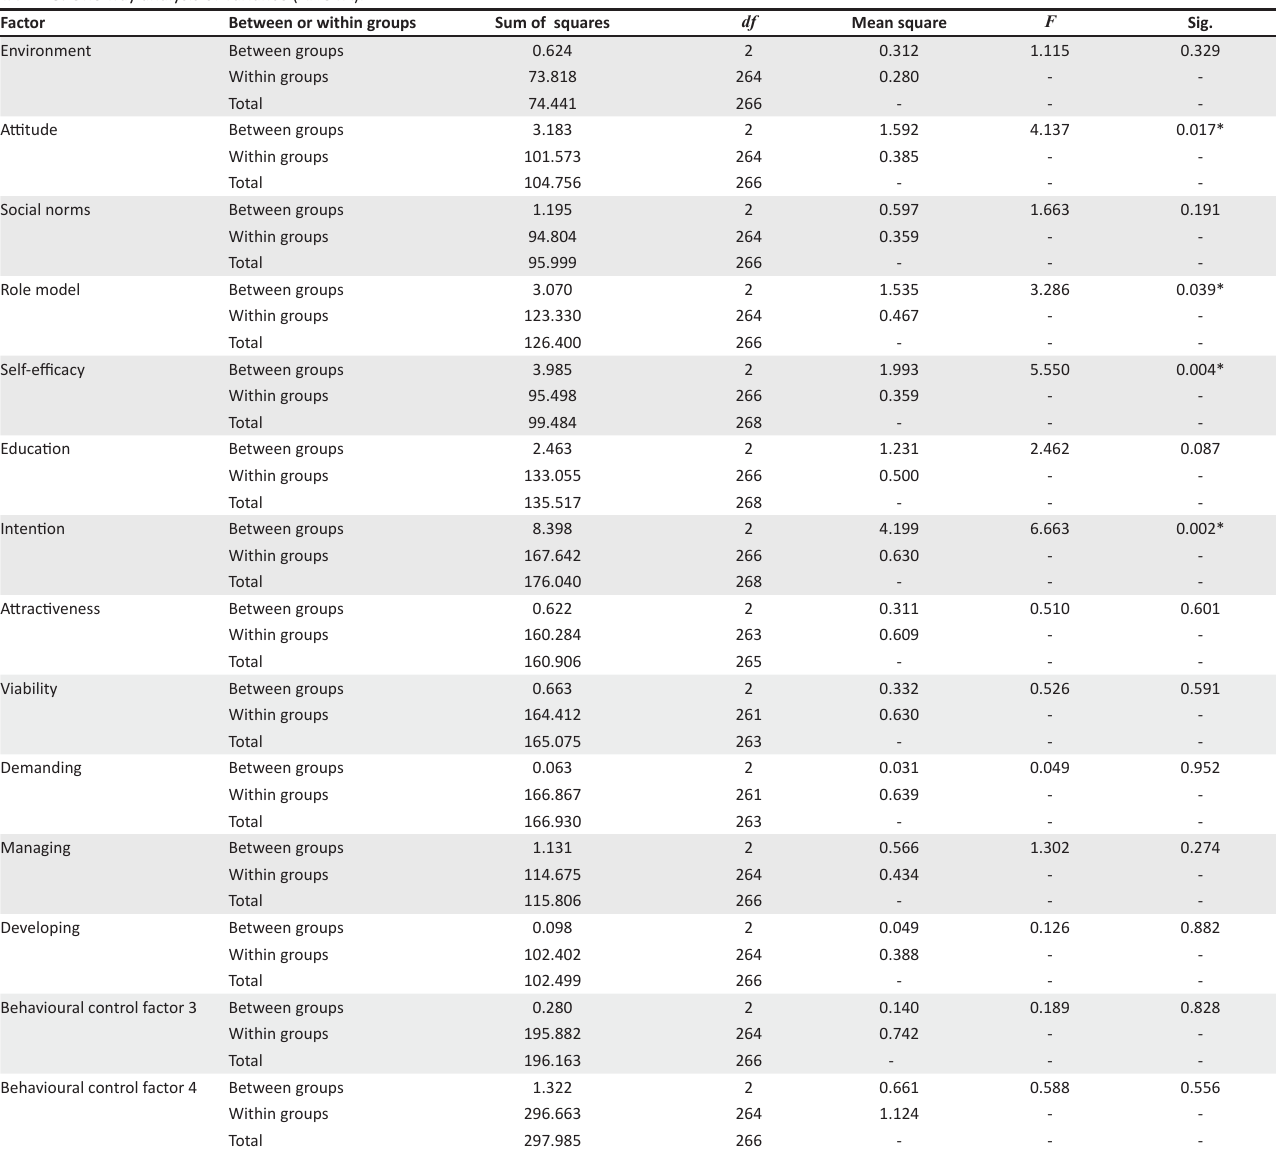
TABLE 8: One way analysis of variance (ANOVA).